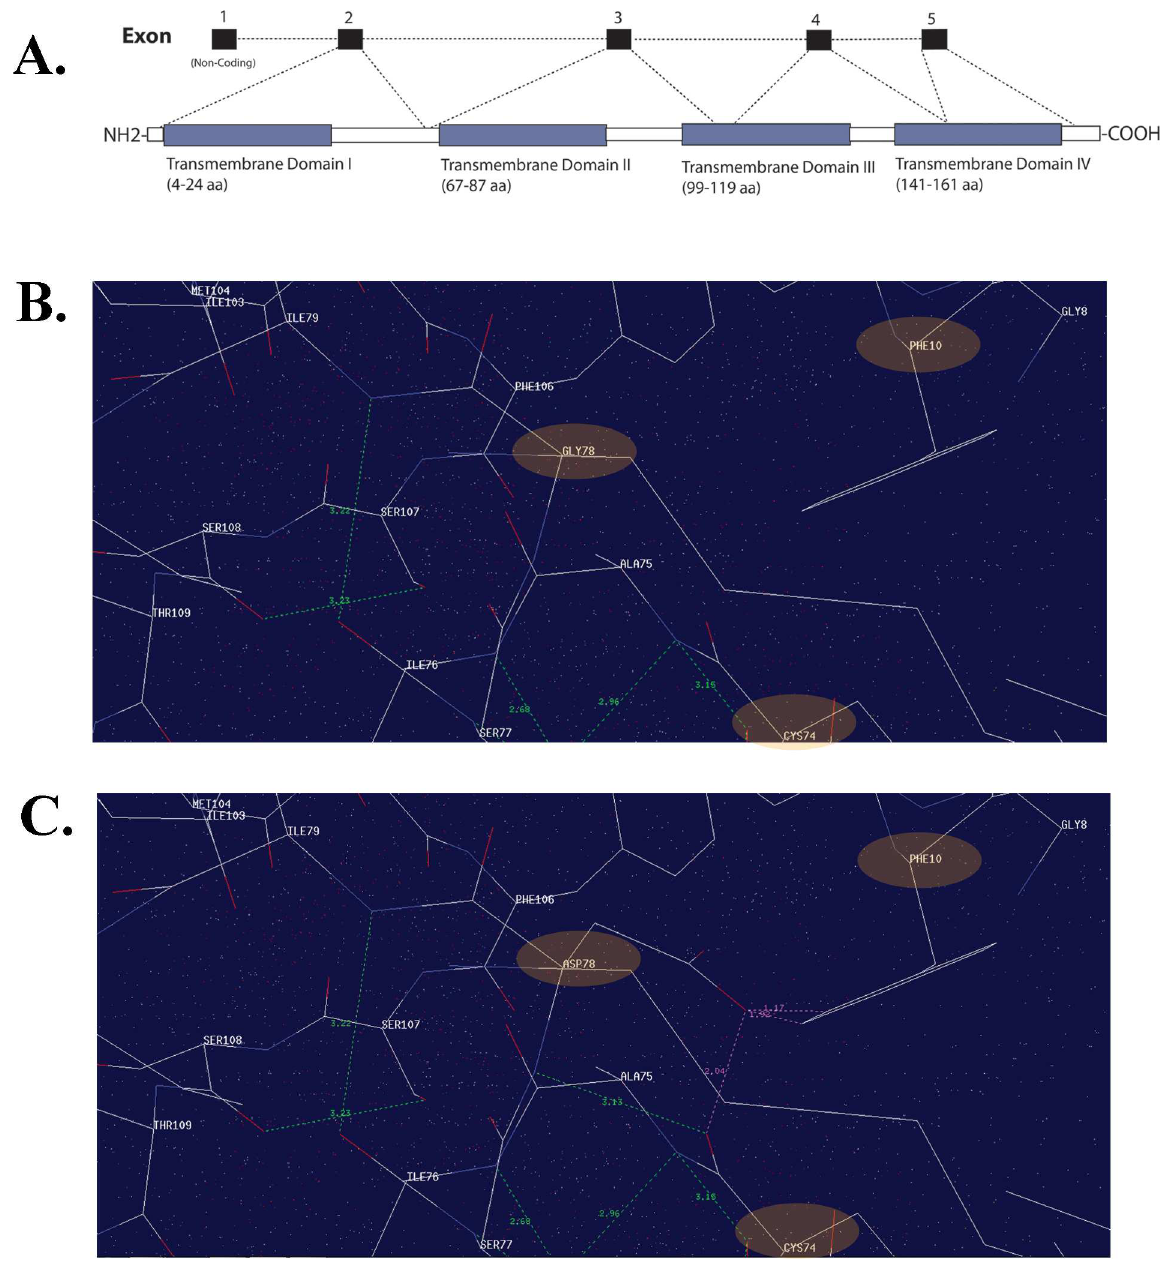
Fig 5. Missense mutation located in the transmembrane domain of MP19 is responsible for congenital cataracts.A ) LIM2 graphicalillustrationshowinggenomic architecture and MP19 protein structure, includingthe four transmembrane domains. Note: the topology has been obtained from Maher et al., 2012; Exp Eye Res.103:115–6. Molecularinteractions of B ) wild-type and C ) mutant MP19 (harboringGly78Asp) suggestinginteractions of the mutant residue (D78) with the phenylalanine (F10) and cysteine (C74)